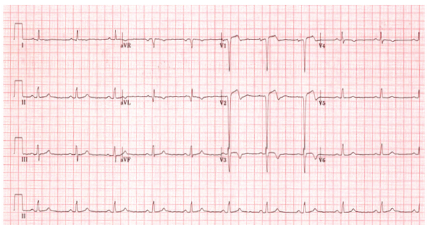
Figure 1: ECG. The ECG on admission showed a Q wave in V1 and V2 and 2mm ST-elevations in V1, V2, and V3 and a terminal negative T wave in I, aVL, V2, V3, and V4, consistent with anteroseptal infarction.